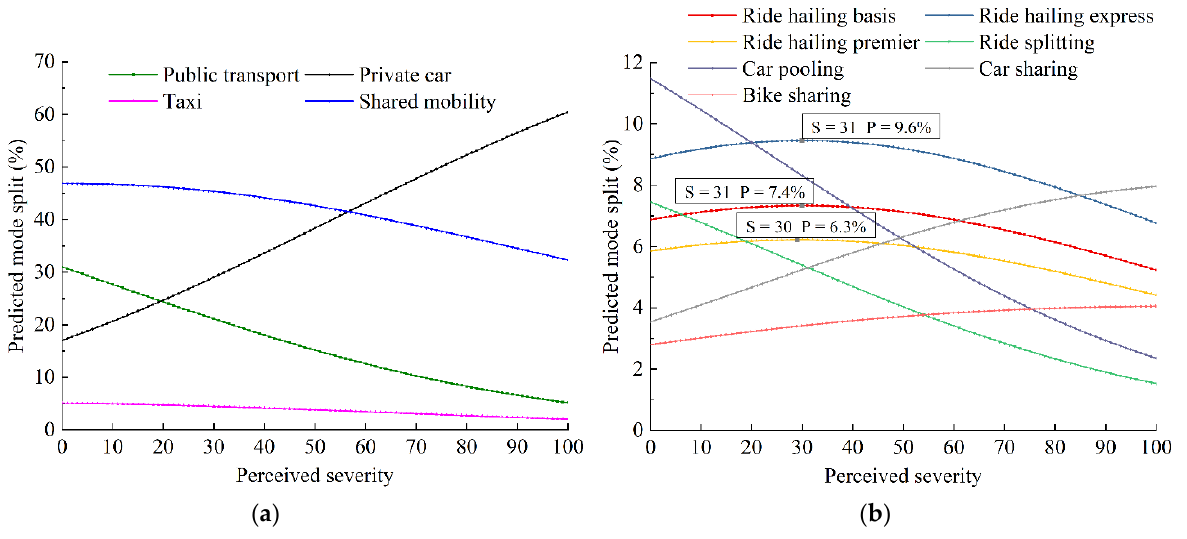
Figure 7. Predicted travel mode split in response to the perceived severity of the pandemic. ( a ) Conventional and shared mobility. ( b ) Shared mobility services.